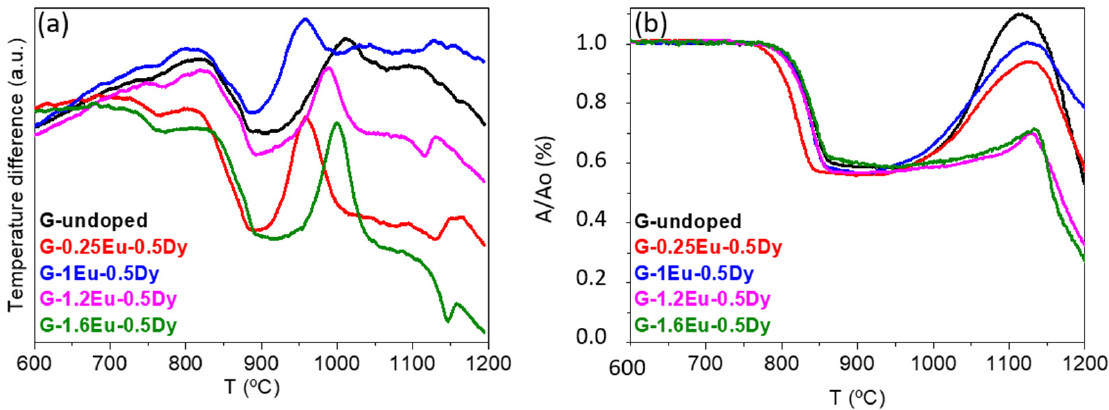
Figure 2. ( a ) DTA and ( b ) HSM curves of G-undoped, G-0.25Eu-0.5Dy, G-1Eu-0.5Dy, G-1.2Eu-0.5Dy, and G-1.6Eu-0.5Dy glasses with different dopant concentrations. Heating rate: 10 ◦ C/min. Table 3. T g , T x , and T c of all glass (ø < 20 μ m) samples determined with DTA.